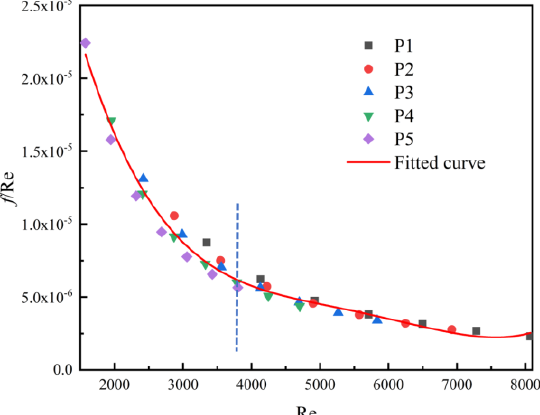
Figure 22. Distributions of friction factor f versus different Reynolds numbers and Prandtl numbers.